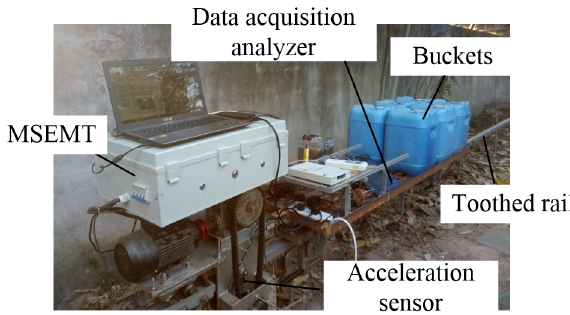
Figure 10. The position of the acceleration sensor. Table 2. Parameters of the MSEMT.